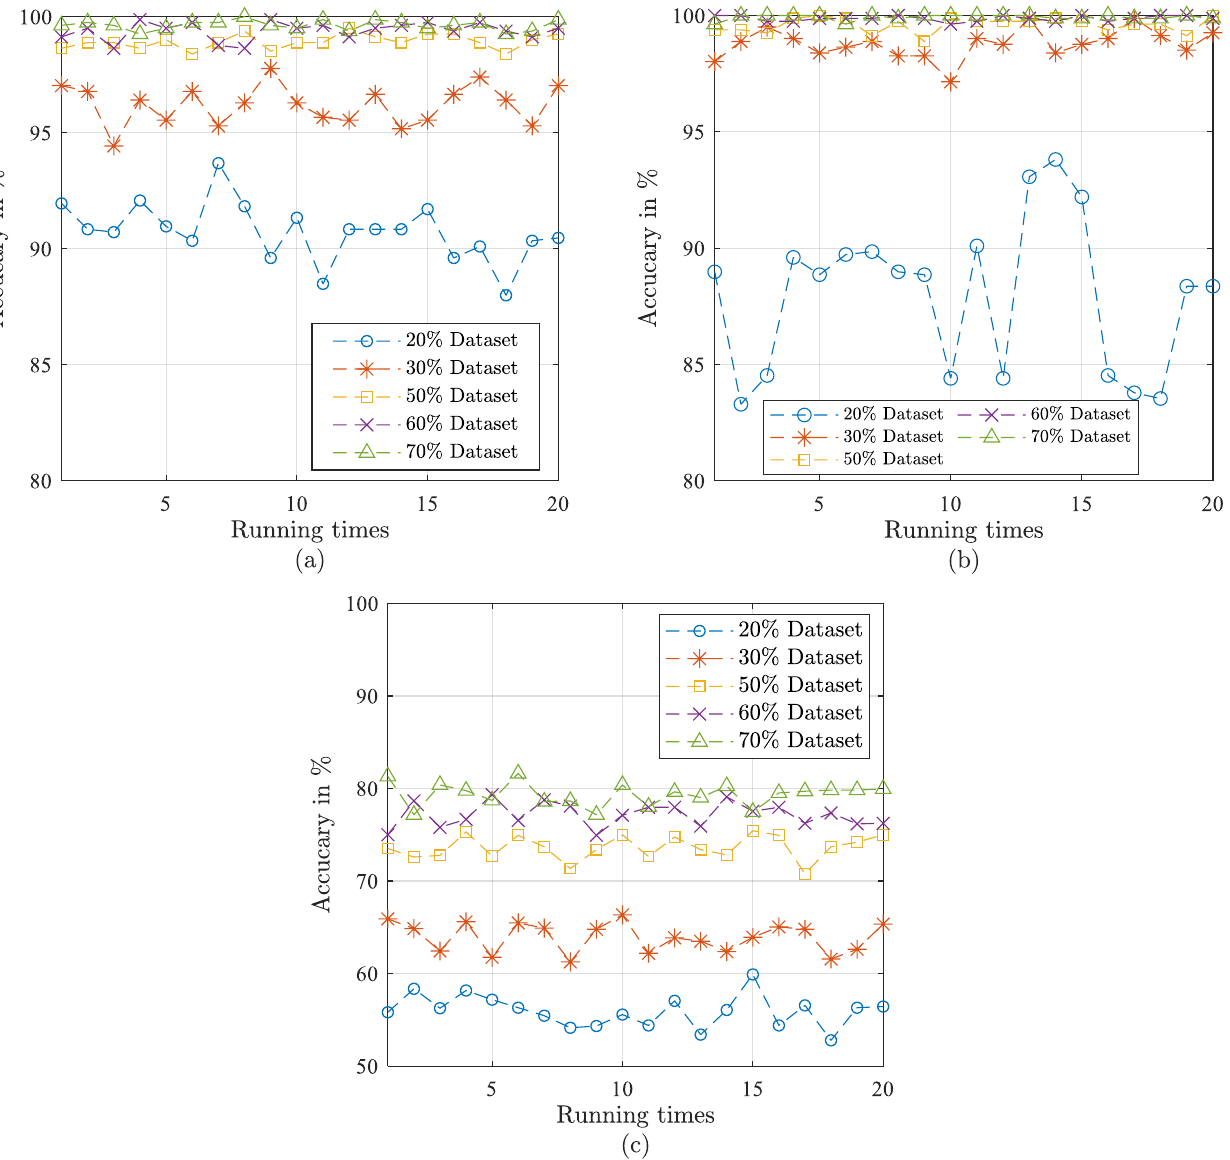
Figure 8. The classification accuracy versus the number of running times: ( a ) SVM algorithm, ( b ) DNN algorithm, and ( c ) decision tree algorithm.